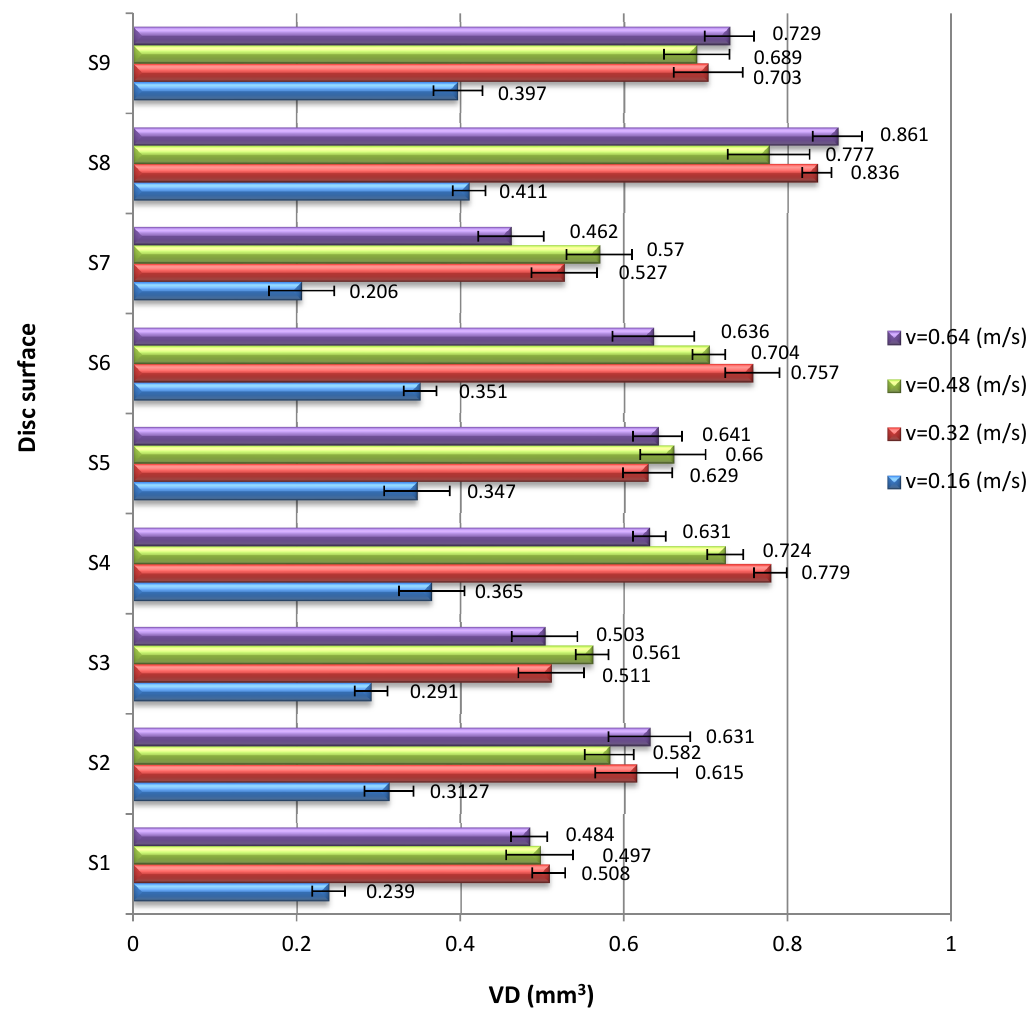
Figure 4. Volumetric wear levels of disc samples. Table 2. Results of tribological